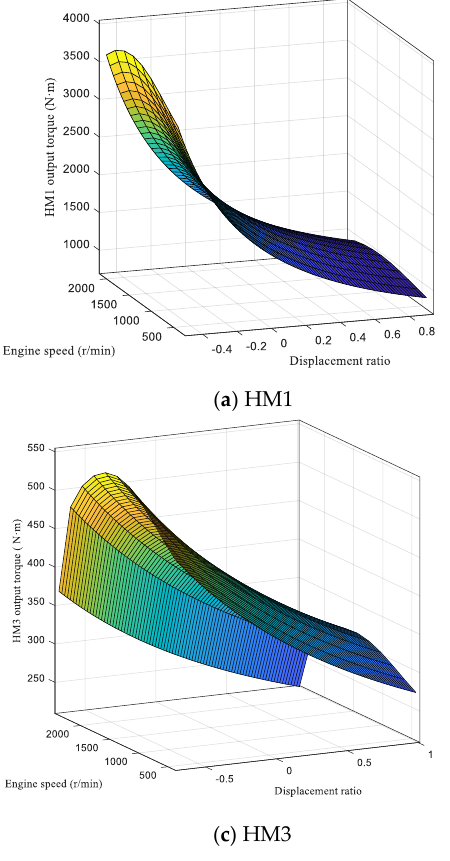
Figure 7. HMCVT torque characteristics.